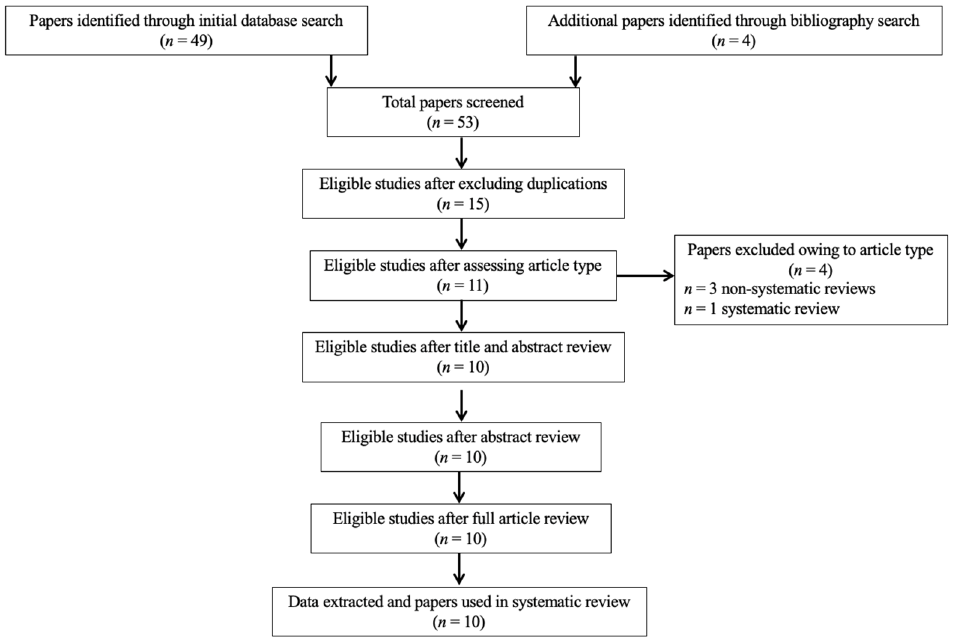
Figure 1. PRISMA flowchart of search strategy for systematic review.